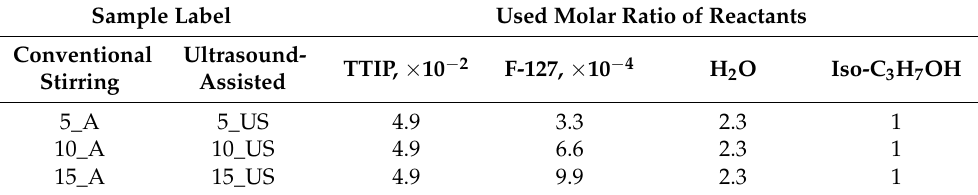
Table 1. Molar ratios of the reactants